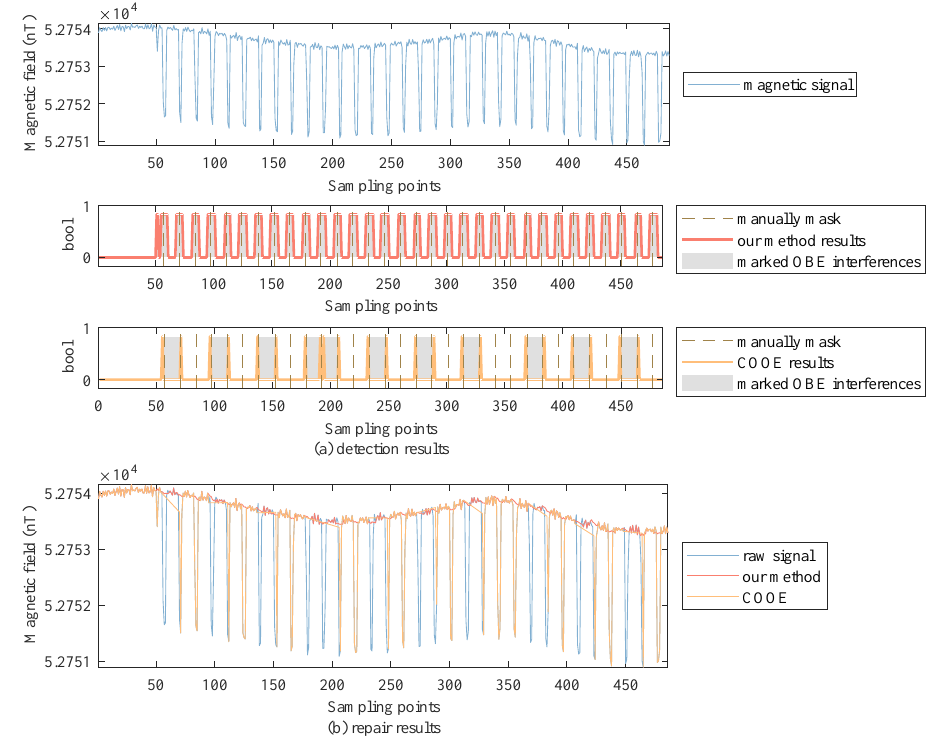
Figure 9. Detection and repair results of the aircraft’s beacon light interferences.